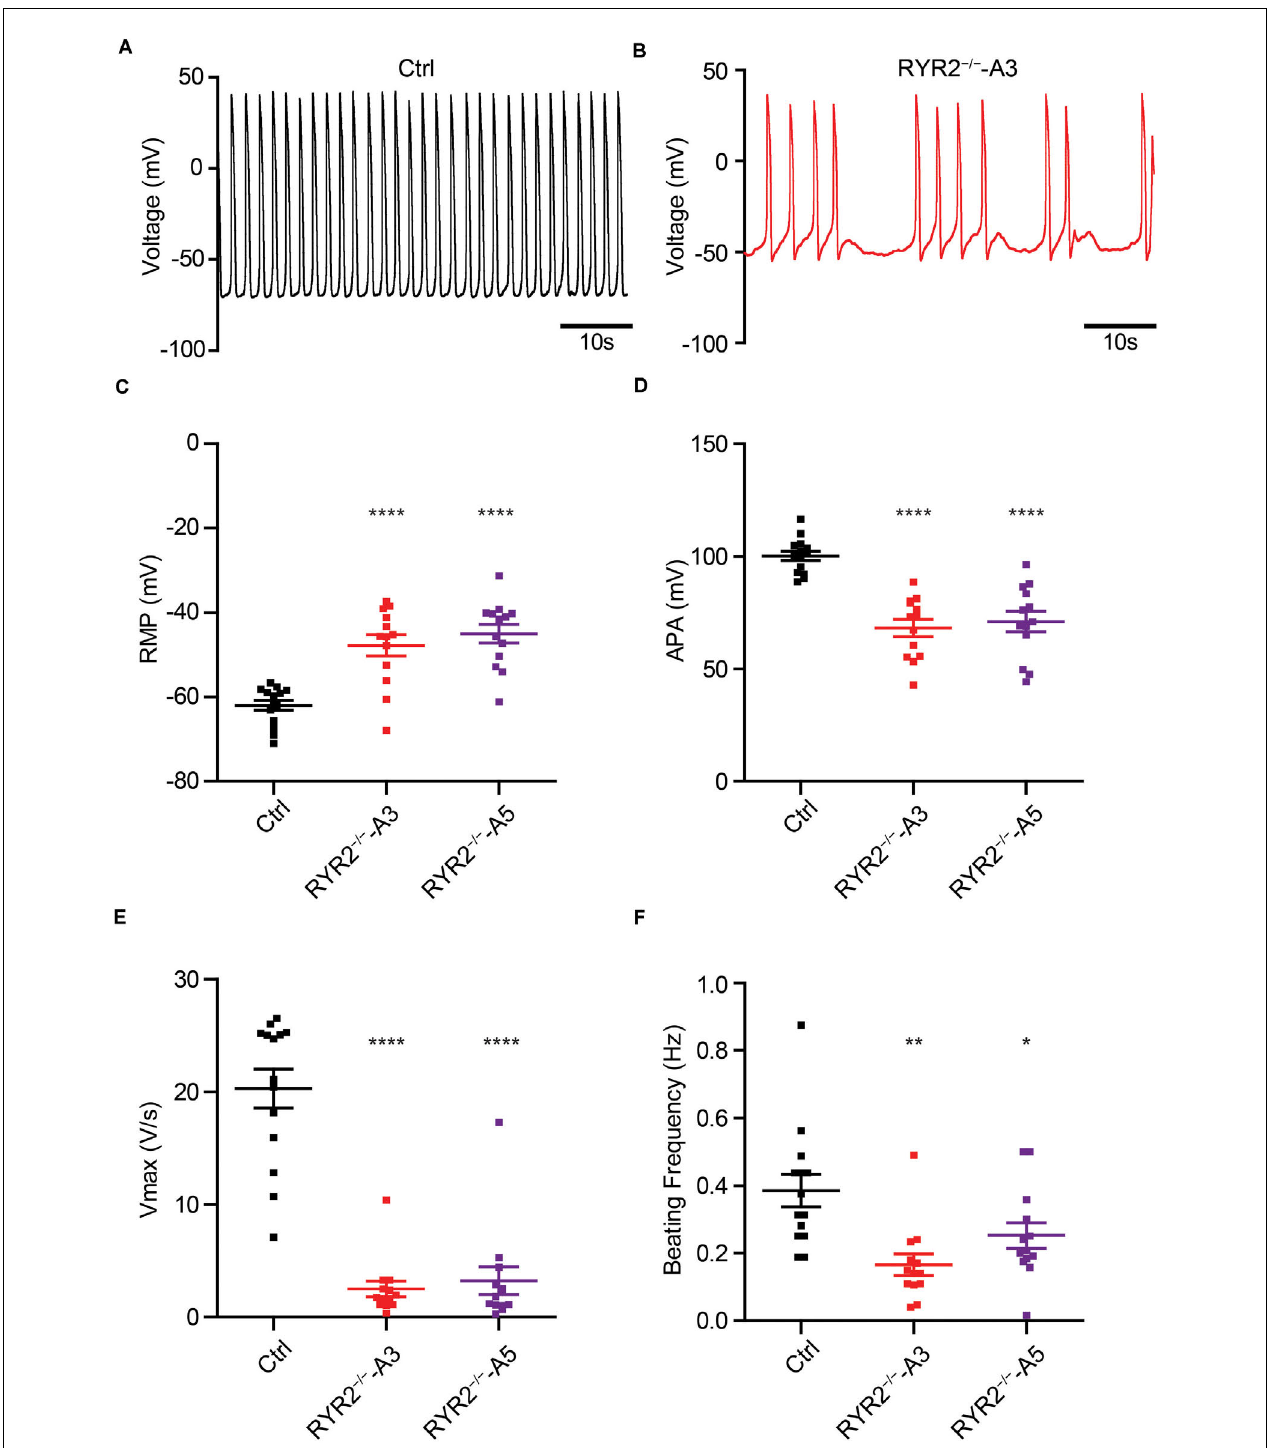
FIGURE 10 | Analysis of action potentials in Ctrl- and RYR2 − / − -iPSC-CMs. (A,B) Representative traces of APs revealed normal beating rhythm in Ctrl-iPSC-CMs (A) and arrhythmic beating in A3 RYR2 − / − -iPSC-CMs (B) . (C–F) Scatter dot plot comparing RMP (C) , APA (D) , maximal upstroke velocity V max (E) , and beating frequency (F) between Ctrl- and RYR2 − / − -iPSC-CMs (Ctrl: n = 12 cells from three differentiation experiments; A3 RYR2 − / − : n = 13 cells from two differentiation experiments; A5 RYR2 − / − : n = 13 cells from two differentiation experiments). * P < 0.05; ** P < 0.01; *** P < 0.001; **** P < 0.0001 by the one-way ANOVA with the Dunnett’s multiple comparison